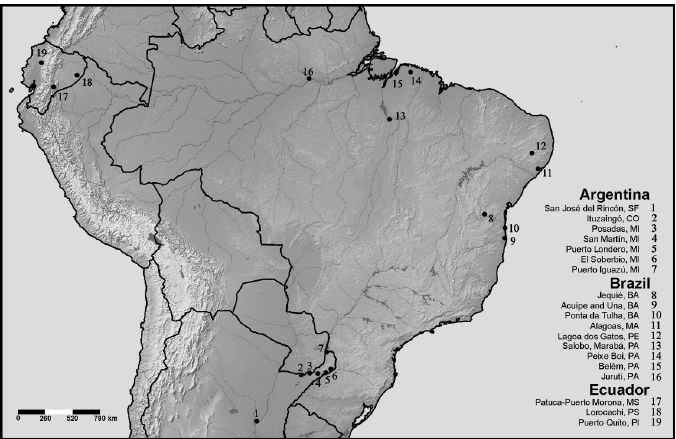
Fig 1. Map of South America showing the collecting localities of the species surveyed in the present study. Santa Fe (SF), Corrientes (CO), Misiones (MI), Bahia (BA), Maceio´ (MA), Pernambuco (PE), Para´ (PA), Morona Santiago (MS), Pastaza (PS), Pichincha (PI). For additional voucher information see the S1 File. The map was created using SimpleMappr (https://www.simplemappr.net), an online tool to produce publication-quality point maps licensed under CC0 1.0 (Public Domain